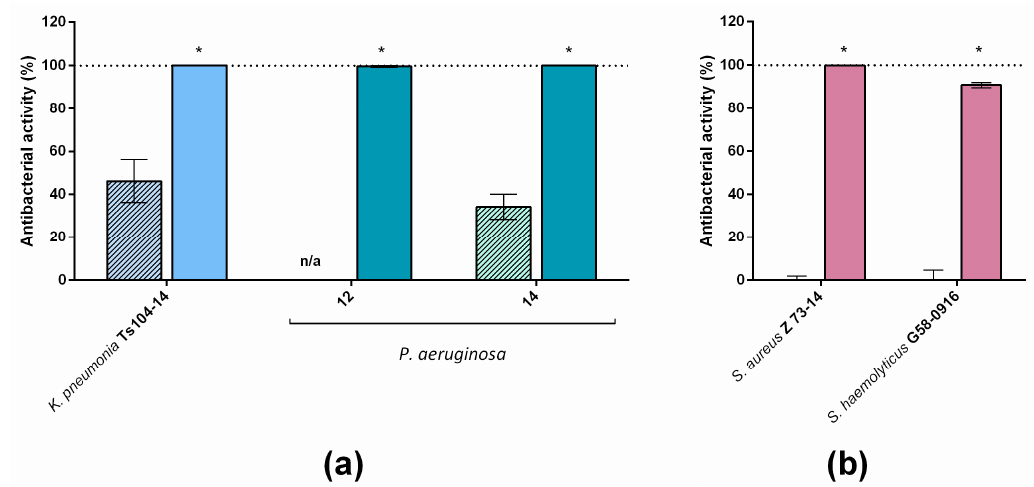
Figure 6. Bactericidal activity of LysECD7-8his (hatched bars) and LysECD7-SMAP (empty bars) on the recalcitrant strains of Gram-negative ( a ) and Gram-positive ( b ) bacterial isolates diluted in 20 mM Tris HCl bu ff er pH 7.5. All proteins were assessed at a concentration of 50.0 µ g / mL and the culture dilution was 1 to 3 × 10 5 CFU / mL. For all experiments, the mean values are shown from three independent experiments ± SD. n / a, no bactericidal activity detected. An asterisk (*) indicates a significant e ff ect on bactericidal activity compared to the LysECD7-8his enzyme ( p < 0.05, Mann–Whitney